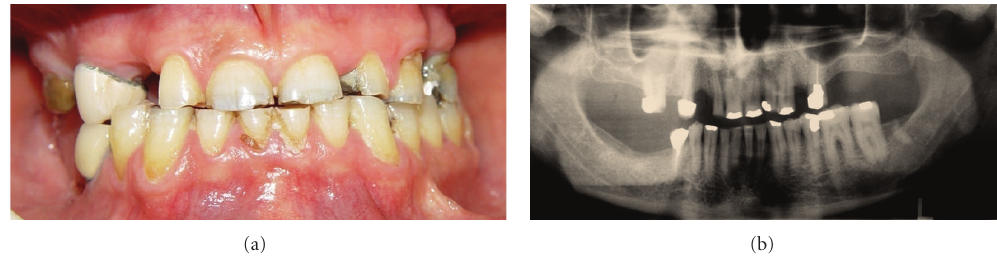
Figure 1: Frontal view of teeth in occlusion (a) and panoramic radiograph (b) before treatment.